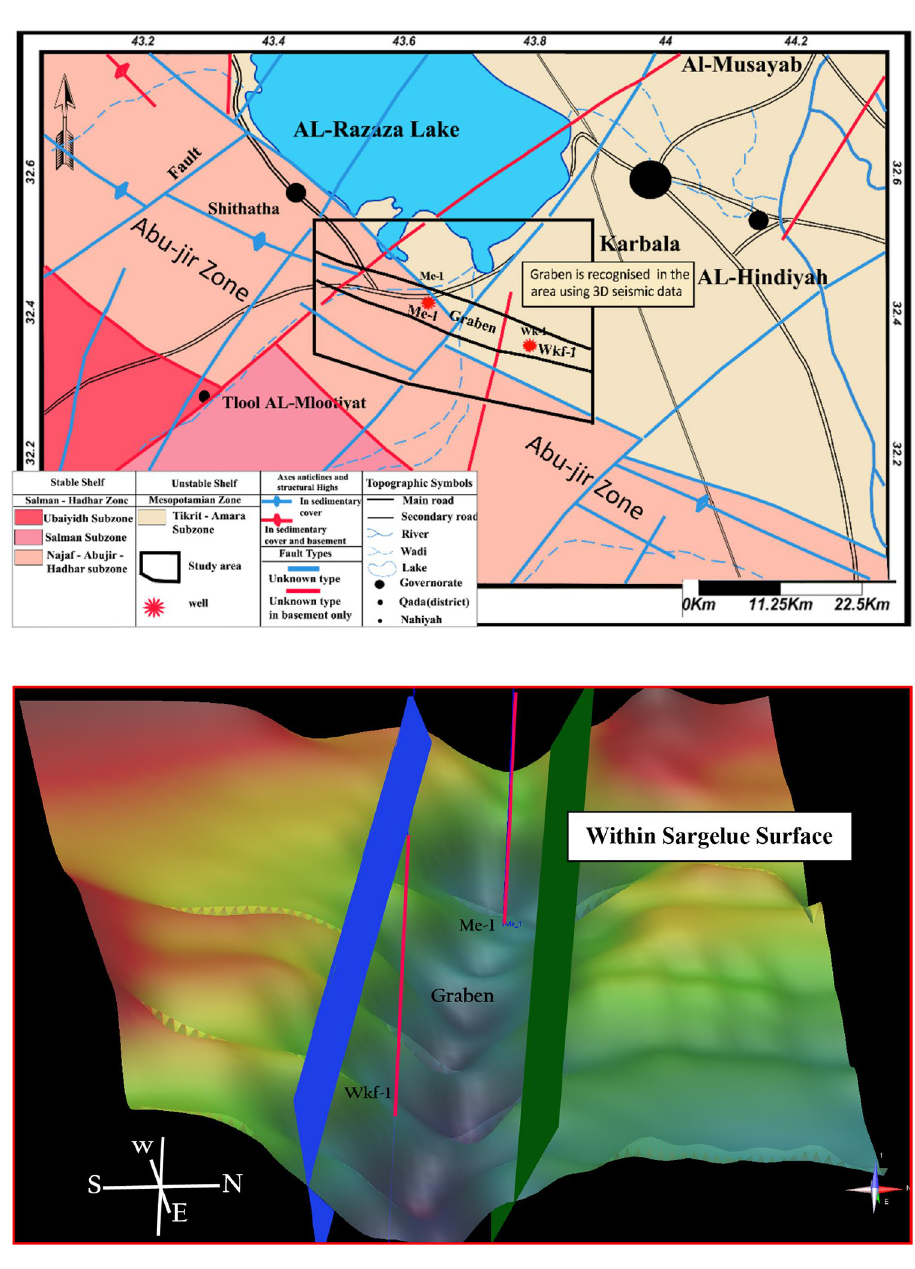
Fig. 6 Tectonic map of a study area (after GEOSURV 1996). Projected on it, the graben system effect on Jurassic suc- cession in Merjan area which has been recognized using 3D seismic data